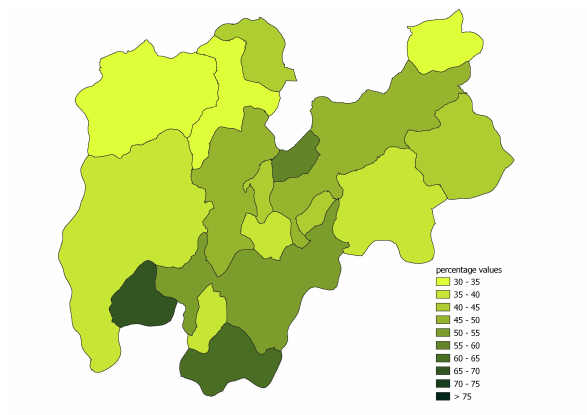
Figure 7. Forest density in the Trentino region according to the “Battisti” map for year 1915.